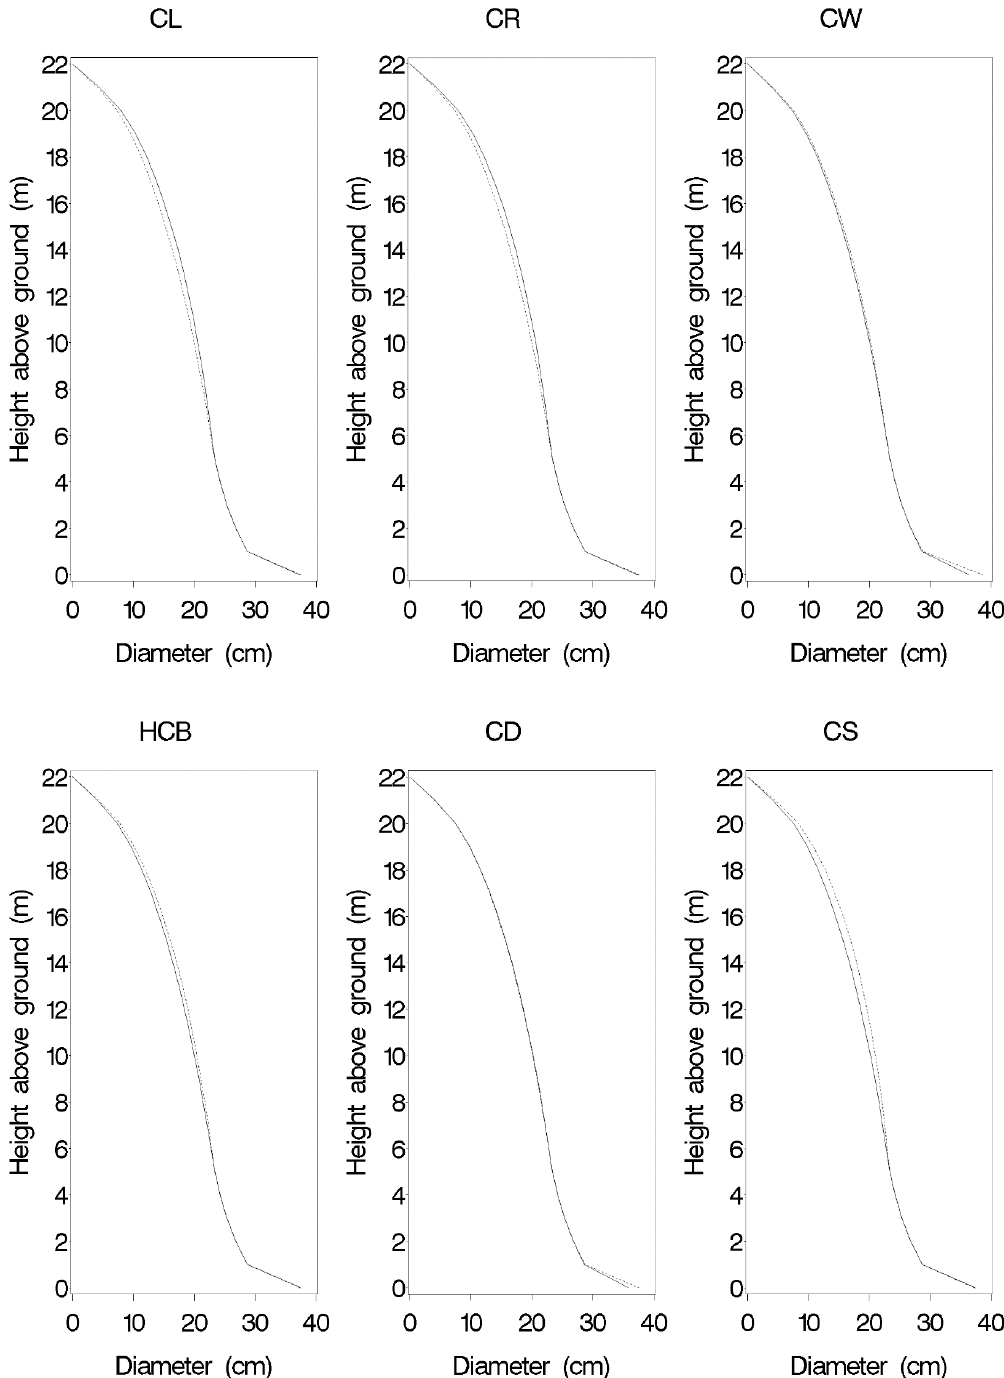
Figure 6. Tree profiles generated from the Clark model with crown variables with the same values of DBH (28.0 cm) and total height (22.0 m) by the different values of CL (4 and 18 m), CR (0.2 and 0.7), CW (2 and 12 m), HCB (6 and 18 m), CD (5 and 22 cm), CS (0.6 and 1.6) for Korean spruce.